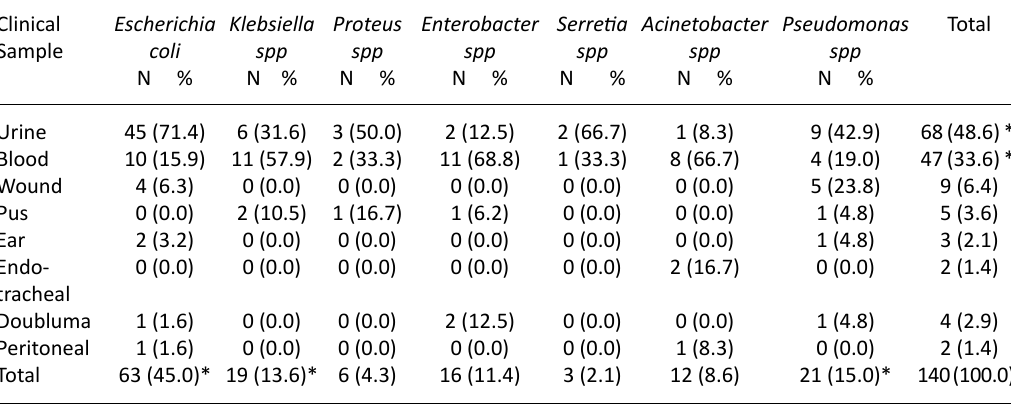
Table 2. Distribution of Organisms Isolated from various Clinical sample Clinical